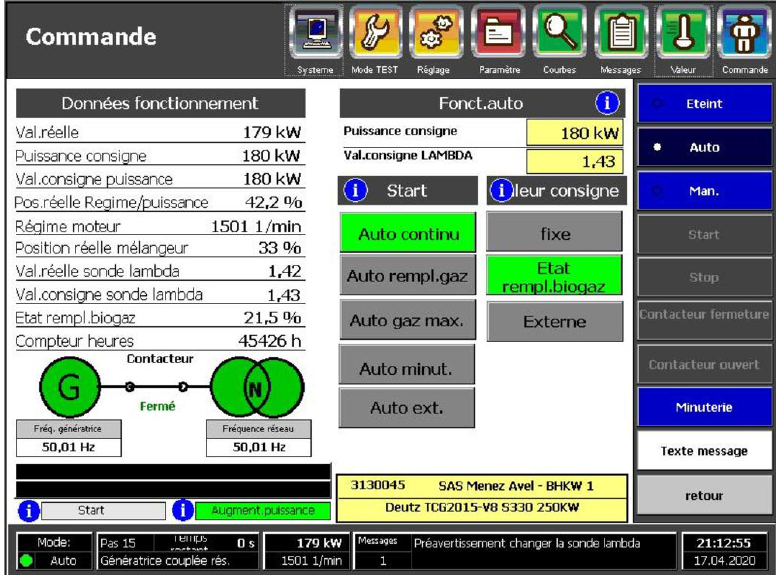
Figure A6. Screenshot of open VNC-controlled SCADA found with